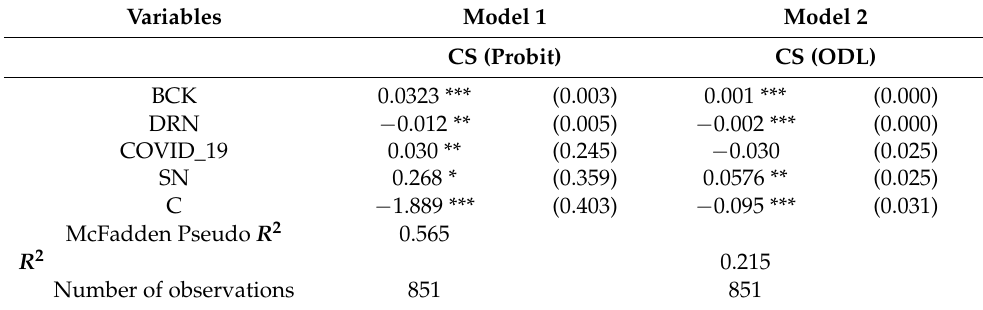
Table 7. Regression analysis